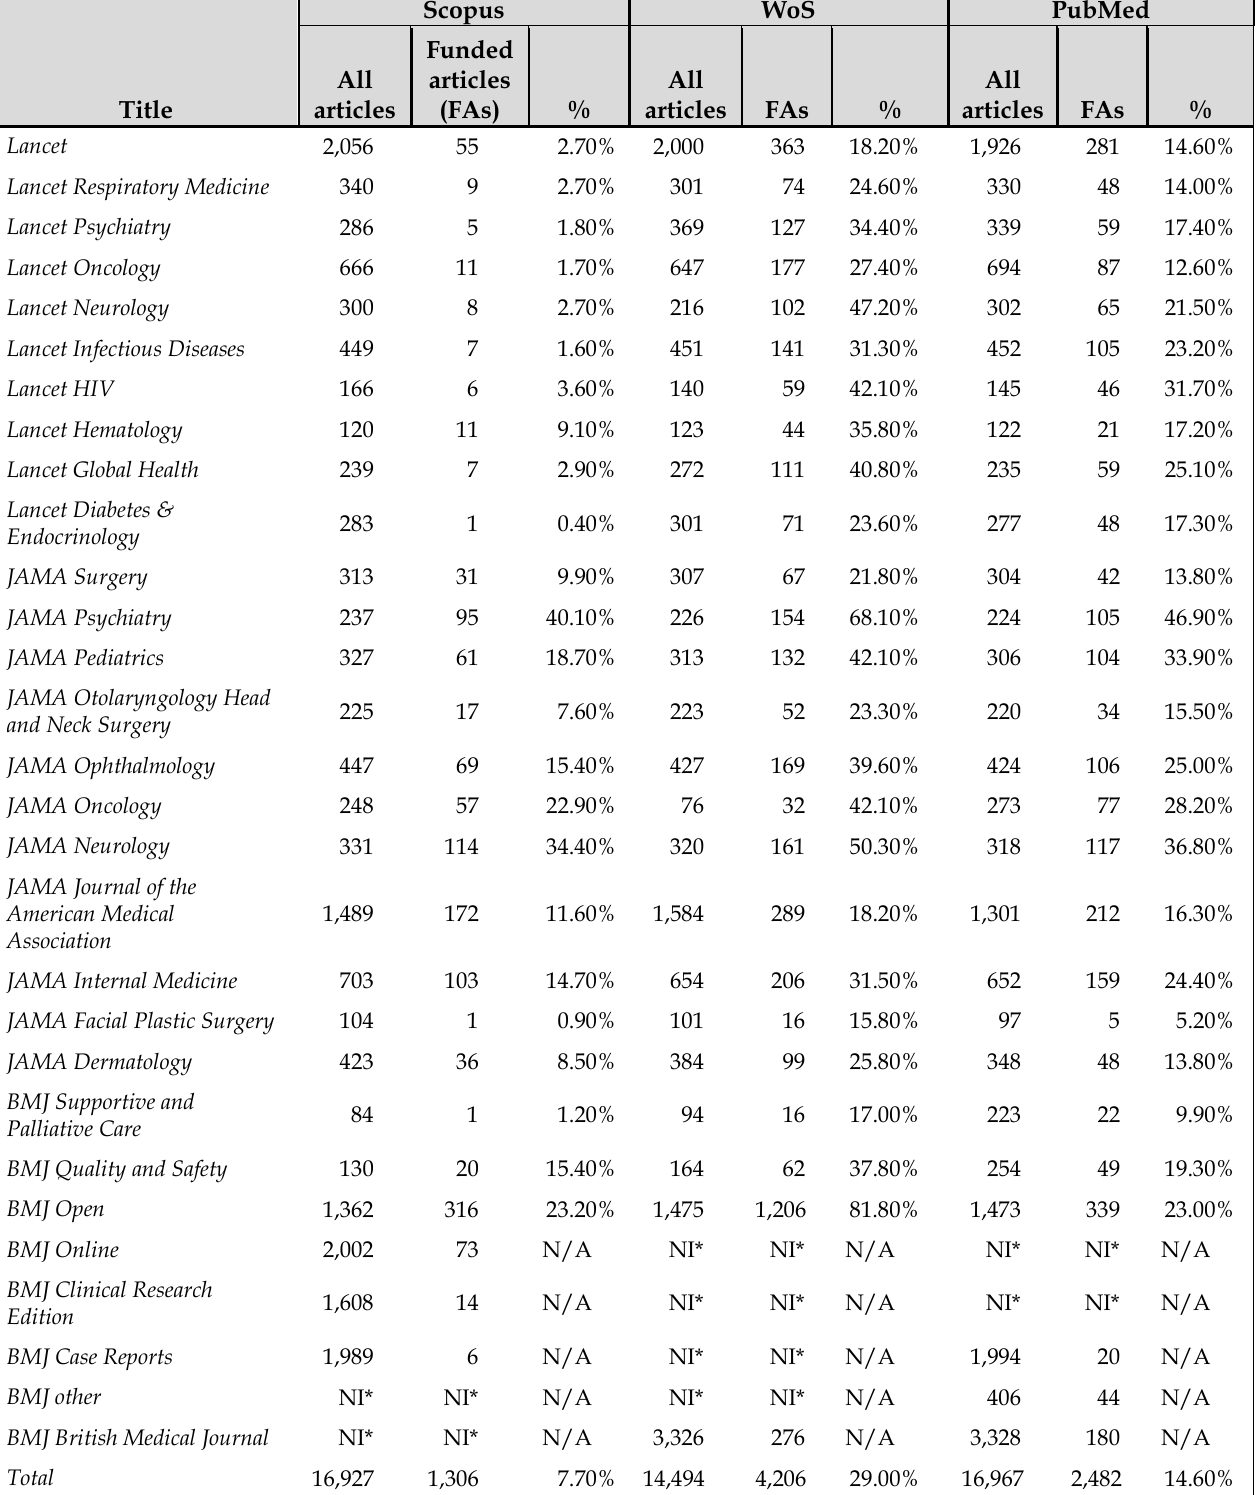
Table 2 Numbers of all articles and funded articles (FAs) published in 2015 for three families of